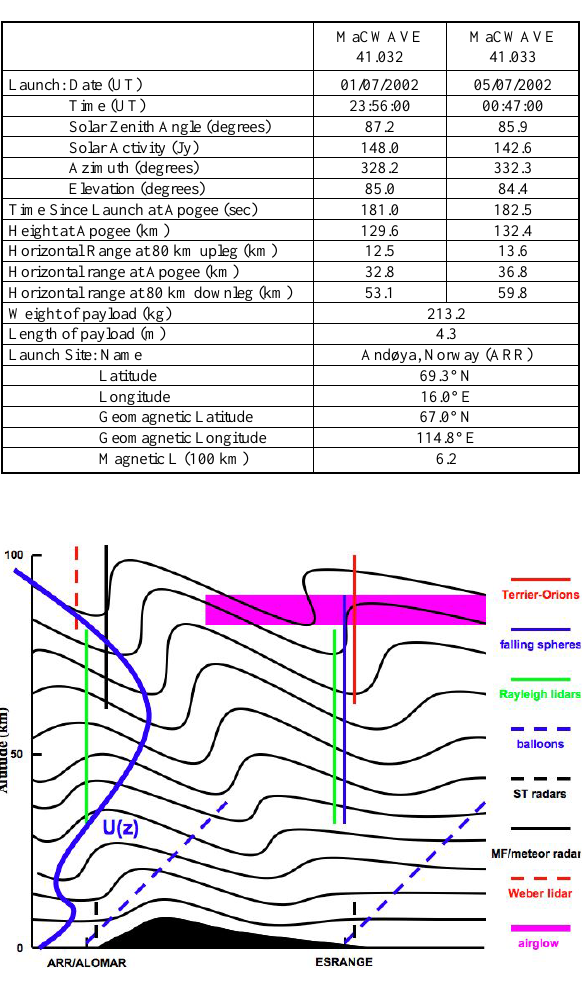
Table 1. MaCWAVE summer launch and rocket information.